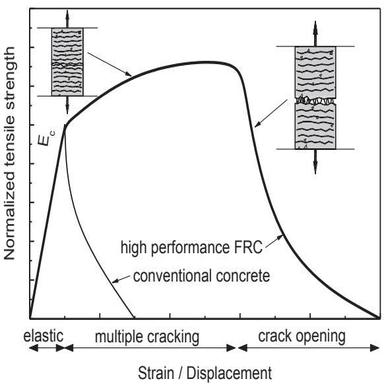
Behaviour of UHPFRC in tension (after).